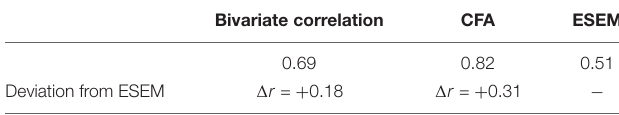
TABLE 1 | Factor correlations obtained from bivariate correlation, CFA, and ESEM. Bivariate correlation CFA ESEM 0.69 0.82 0.51 Deviation from